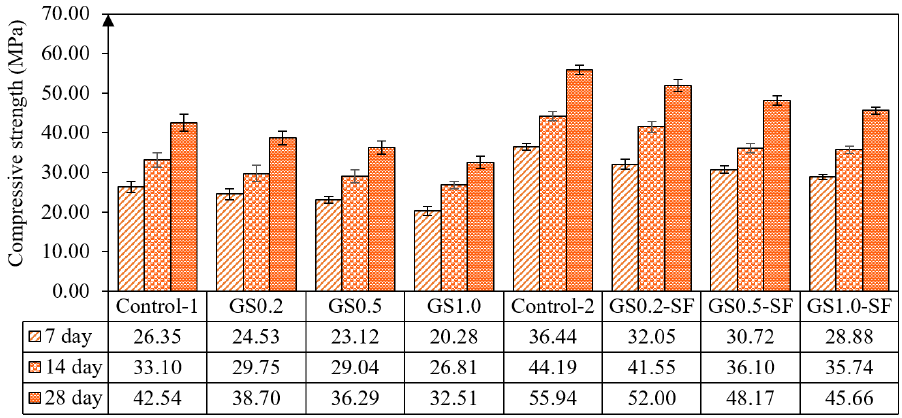
Fig. 4. Compressive strength of CRT